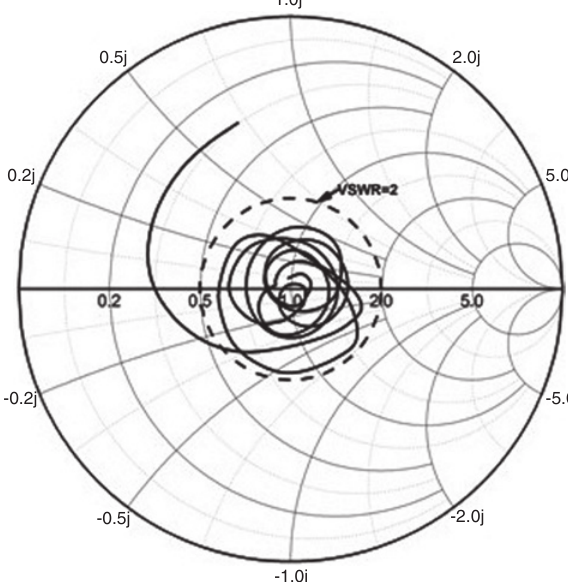
Figure 12: Measured smith chart of the antenna. electrical area unit. The equation is presented in (1). The calculated BDR of the proposed antenna is 941.5291.